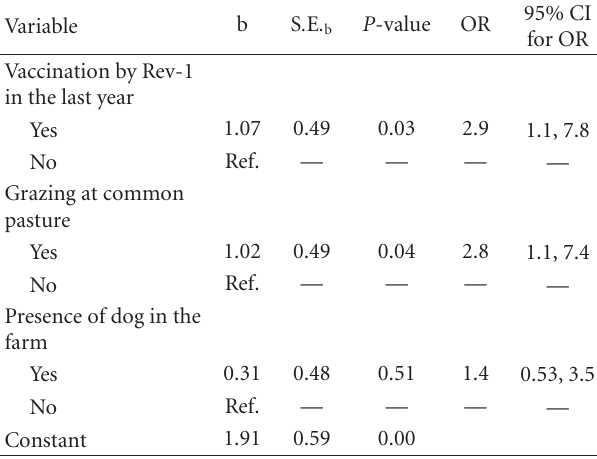
100100100100100100100100100100100100100 100100 100100100100100100100100100100100100100100 Figure 3: Nucleotide similarity of 929 nucleotides of 16s rRNA gene of Brucella spp. 1: B. abortus S19, 2: B. canis , 3: B. cetaceae , 4: B. melitensis biovar abortus , 5: B. melitensis biovar neotomae , 6: B. melitensis biovar abortus , 7: B. melitensis biovar canis , 8: B. melitensis biovar suis , 9: B. melitensis biovar-1 , 10: B. melitensis -Jordan, 11: B. melitensis , 12: B. melitensis biovar ovis , 13: B. microti , 14: B. ovis , 15: B. pinnipedialis , 16: B. suis . Table 1: Final logistic regression model for risk factors associated with the B. melitensis positivity of small ruminant flocks in Mafraq region of